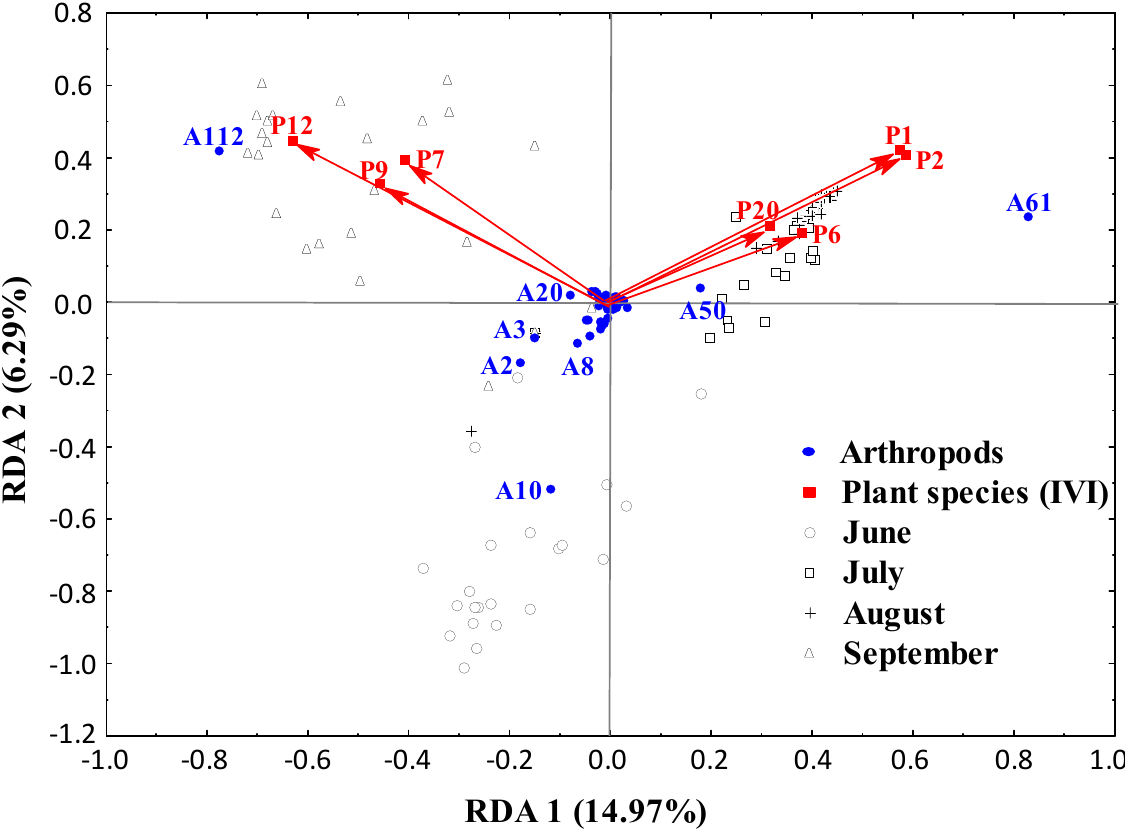
Figure 3. RDA triplot showing the relationships between the Hellinger-transformed abundance of arthropods (response variable) ( • ), the IVI of plant species (explanatory variables) ( (cid:4) ), and sample points in June, July, August, and September ( , , +, , respectively ). The percentage of variance explained by the two first canonical axes (RDA 1 and RDA 2) is indicated between brackets in the axes titles. P1- Alternanthera tenella , P6- Centratherum punctatum , P2- Louteigia ballotifolia , P7- Solanum lycocarpum , unidentified species 2 (P20), P9- Pavonia cancellata , P12- Chamaecrista rotundifolia . A2, A3, A8-Hymenoptera morphospecies; A10-Diptera morphospecies; A20-Unidentified; A50, A61-Collembola morphospecies; A112-Unidentified larvae.